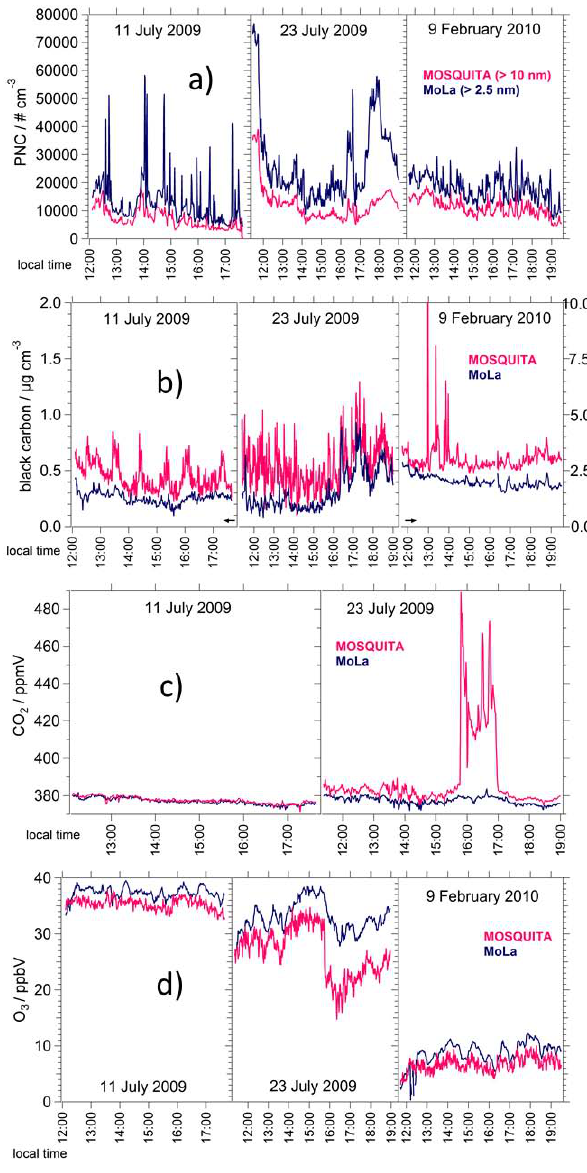
Fig. 1. Time series of the particle number concentration (PNC, panel a), black carbon concentration (panel b), CO 2 mixing ratio (panel c) and O 3 mixing ratio (panel d) recorded during the inter- comparison time periods on 11 July 2009, 23 July 2009 and 9 Febru- ary 2010 by the devices in MoLa (blue) and MOSQUITA (pink). CO 2 data recorded by MOSQUITA are only available during the summer